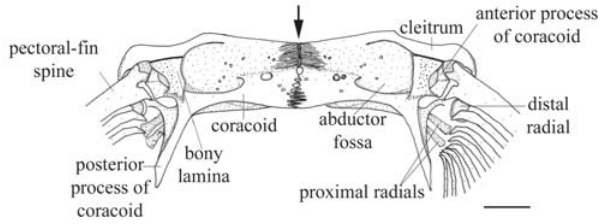
Fig. 47. Ventral view of the pectoral girdle of Lamontichthys filamentosus (LACM 41741-9, 119.4 mm SL). Arrow points to region of cleithrum and coracoid symphyses. Cartilages not represented. Scale bar = 3 mm.